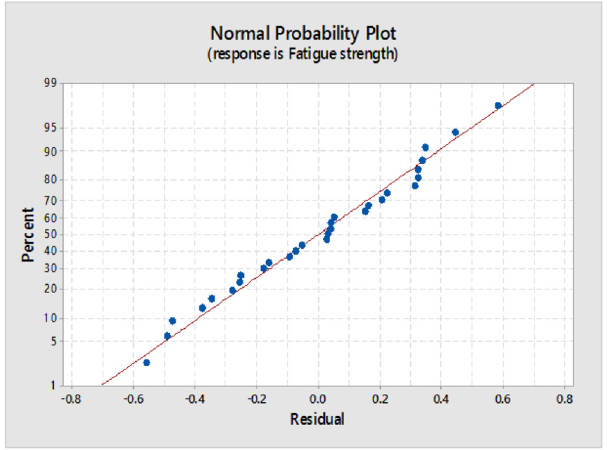
Fig. 7. Normal plot standardized effects.